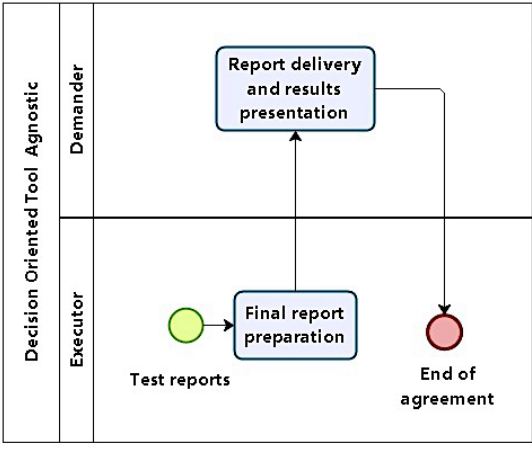
Figure 7. Phase 6: